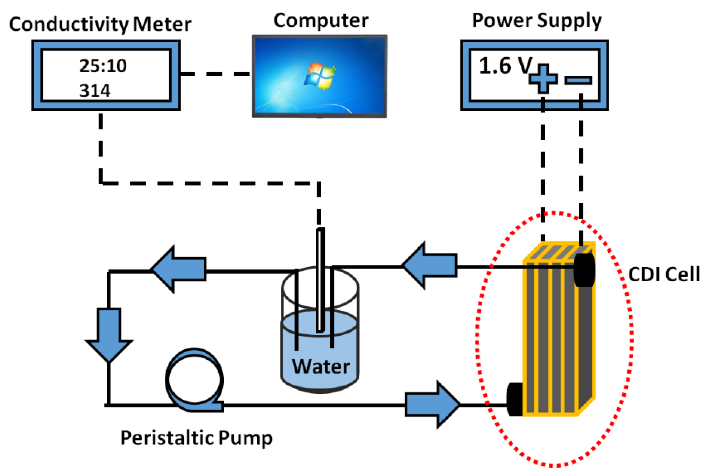
Figure 8. The schematic illustration to evaluate the desalination efficiency using the fabricated electrodes containing various PVDF concentrations.